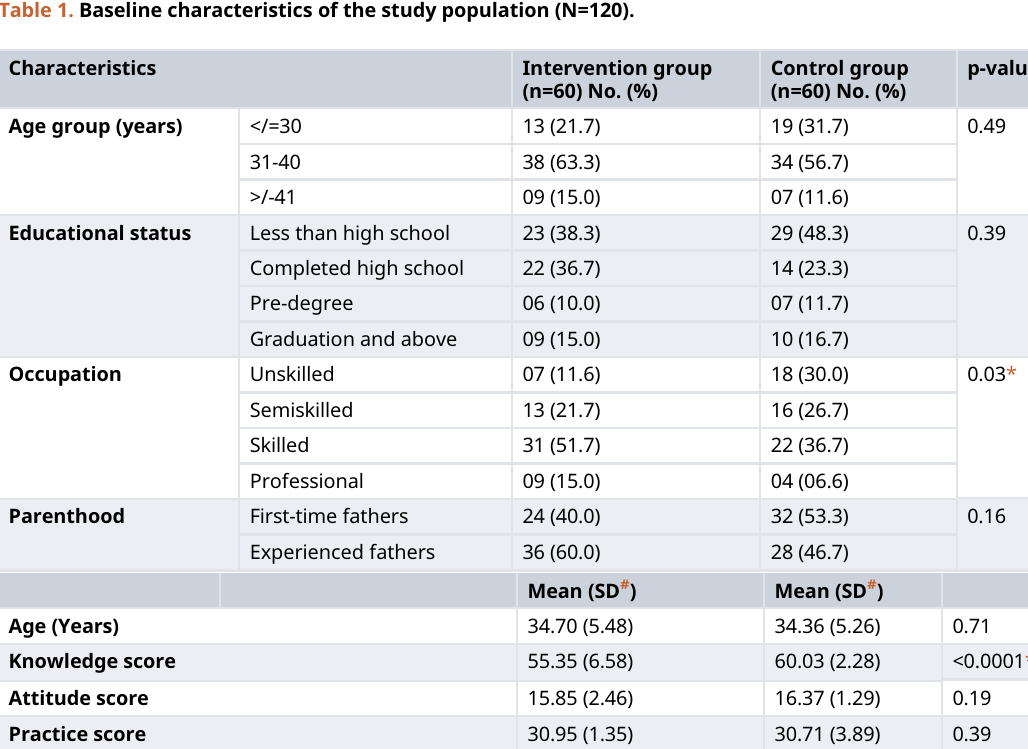
Figure 2. Study CONSORT diagram. IYCF=Infant and Young Child Feeding. Table 1. Baseline characteristics of the study population